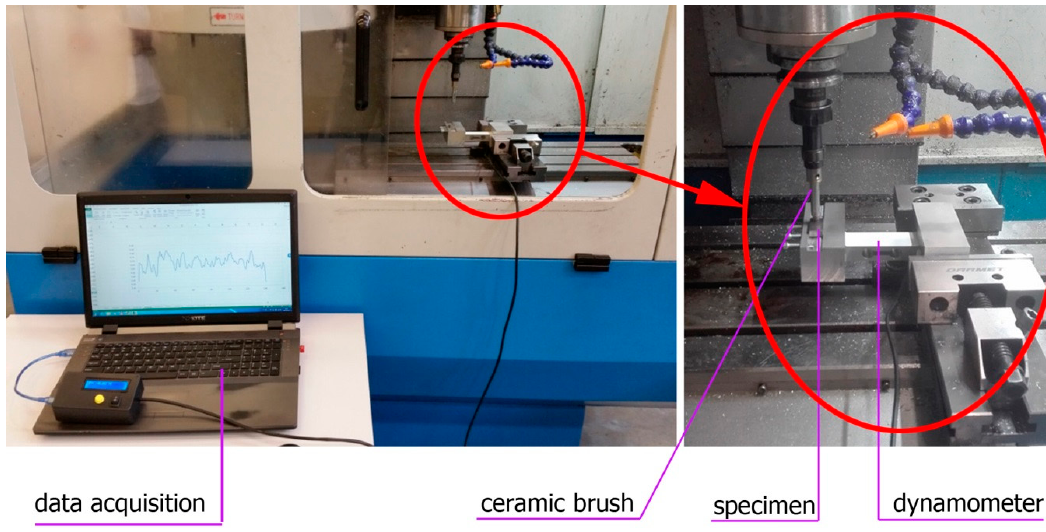
Figure 1. The system for brushing force measurement.